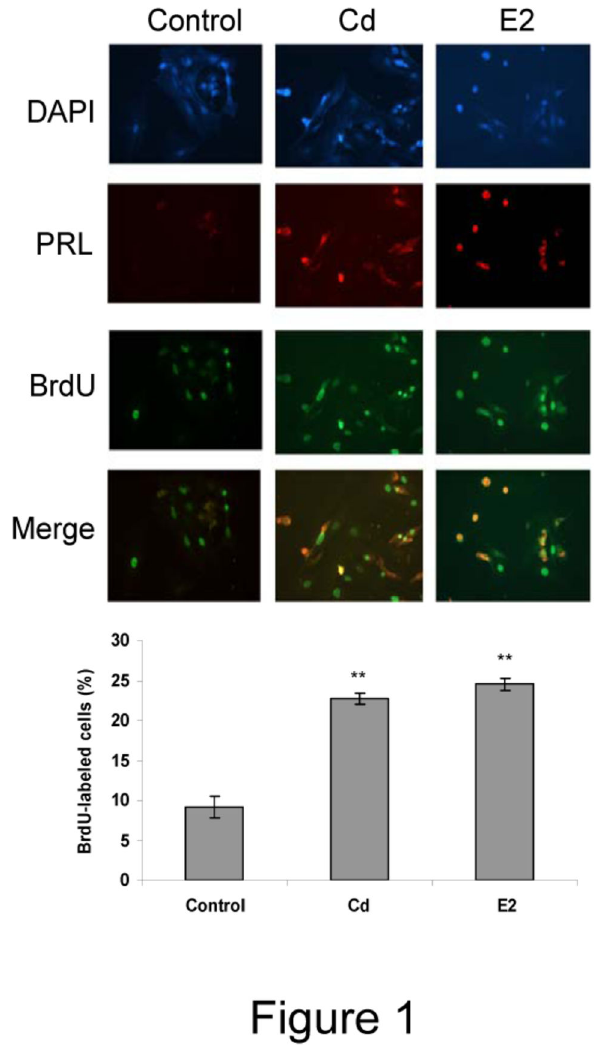
Figure 1. Cadmium stimulates anterior pituitary lactotroph proliferation. Anterior pituitary cells were treated with vehicle (control), 10 nM Cd or 1 nM E2 for 96 h. Cell growth was determined by ICC measuring 24 h-BrdU incorporation. Lactotrophs were identified by prolactin-specific antibody and cell nuclei were stained by DAPI. Pictures are representative of three independent experiments performed in triplicate. Bars represent the mean ± SE of BrdU-labeling index expressed as positive BrdU lactrotroph / total lactotroph cell number x100. ANOVA followed by Tukey-Kramer’s test, **p<0.001 vs. control (N=3).